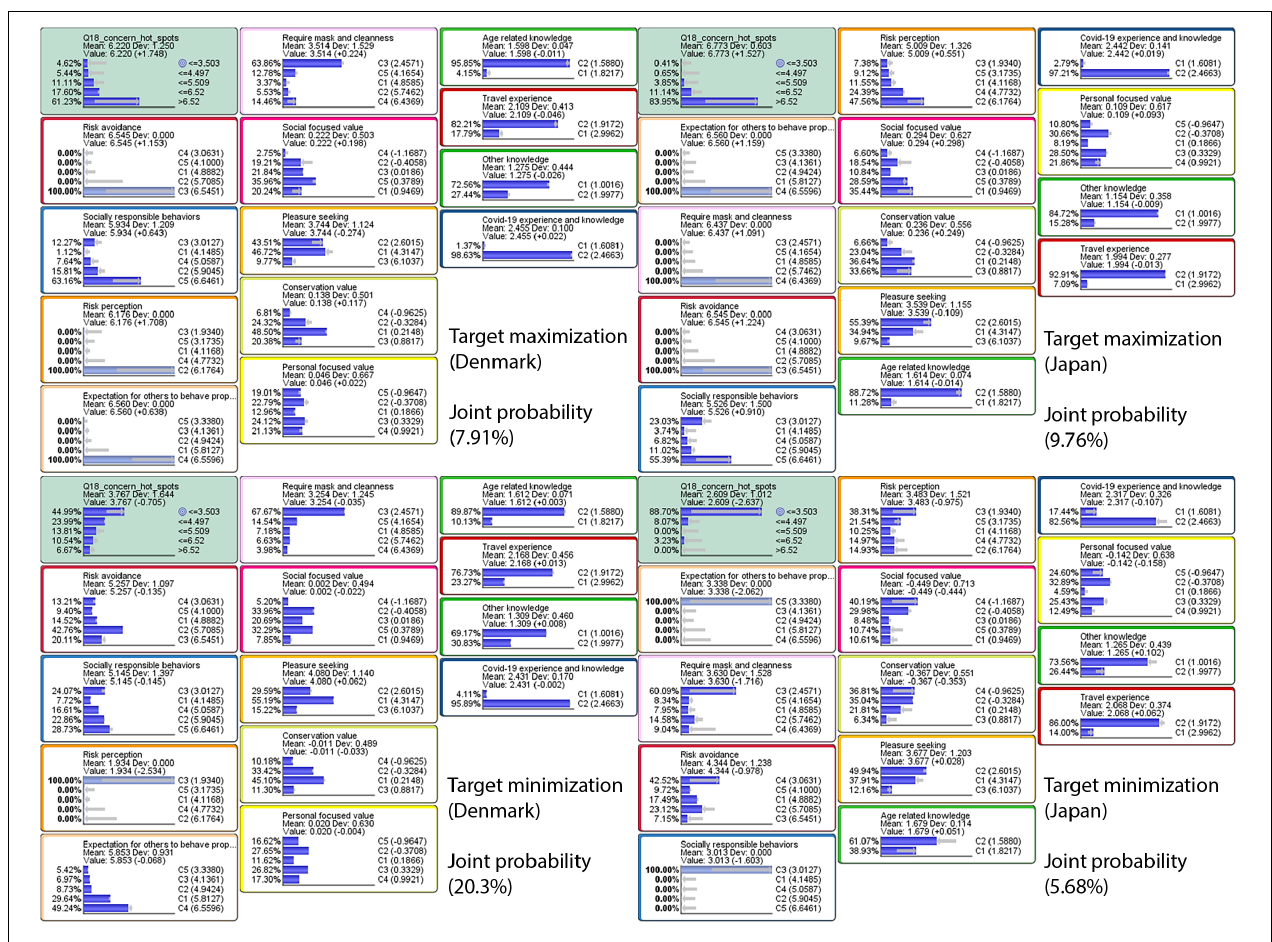
FIGURE 9 | Target optimization scenarios: maximization (upper part) and minimization (lower part) for Denmark (left) and Japan